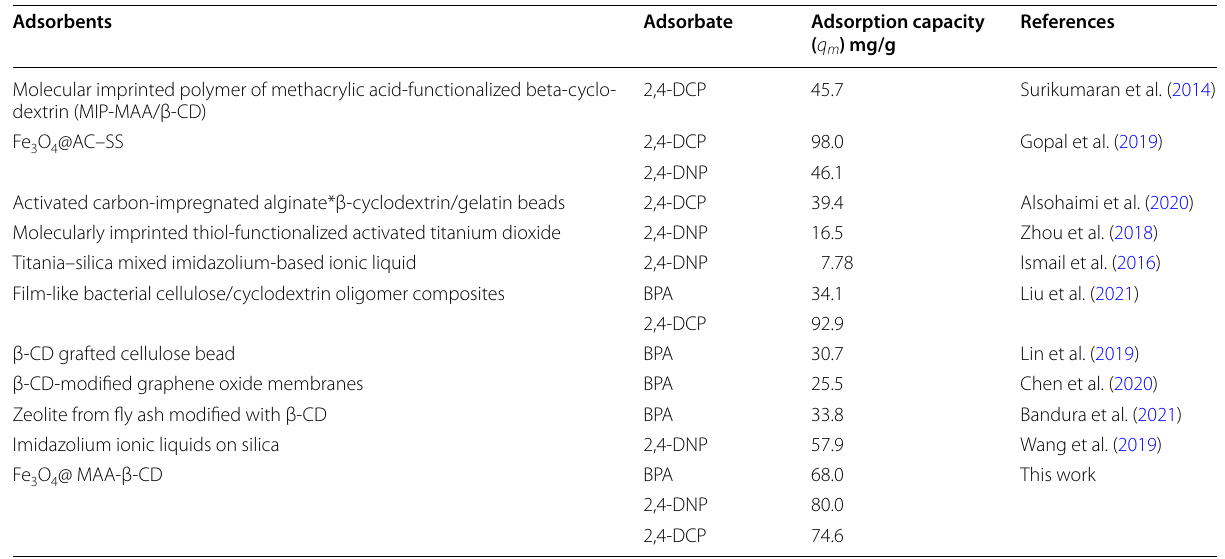
Table 6 Comparison of adsorbent used in this study with other adsorbents used for the removal of phenolic